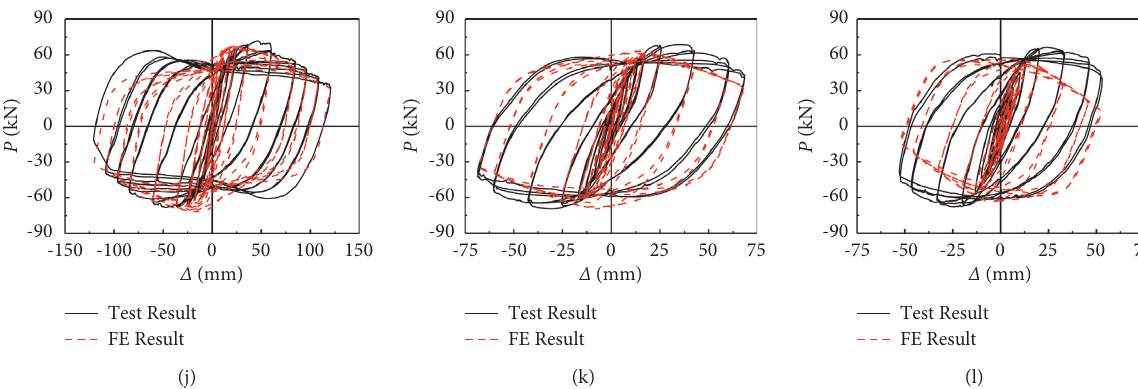
Figure 13: Comparison of simulation results and experimental results of P - Δ curves of specimens. (a) A0 specimen. (b) B0 specimen. (c) C0 specimen. (d) D0 specimen. (e) A1 specimen. (f) B1 specimen. (g) C1 specimen. (h) D1 specimen. (i) A2 specimen. (j) B2 specimen. (k) C2 specimen. (l) D2